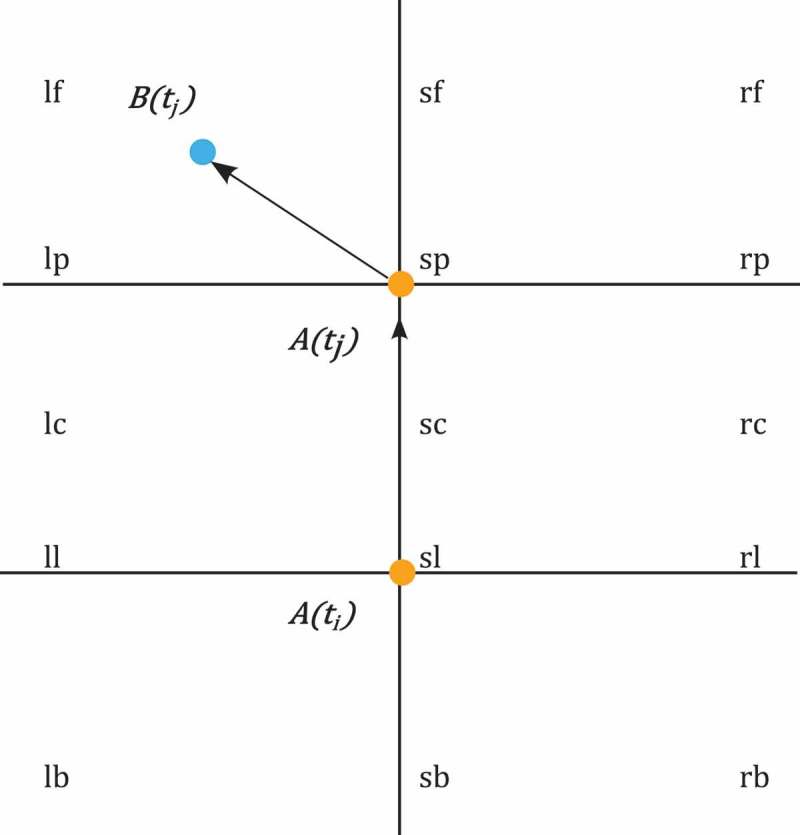
Double cross calculus (based on Freksa 1992).